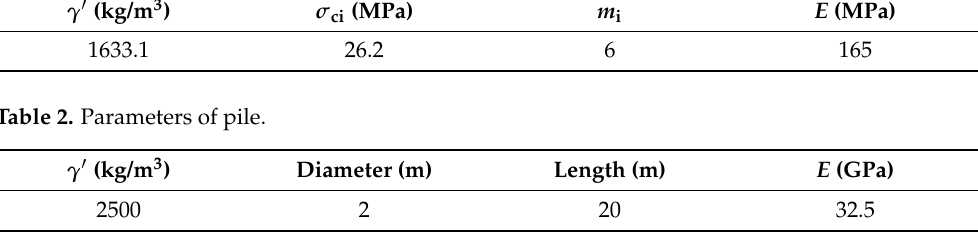
Figure 12. Element meshes of a drilled shaft–rock system.